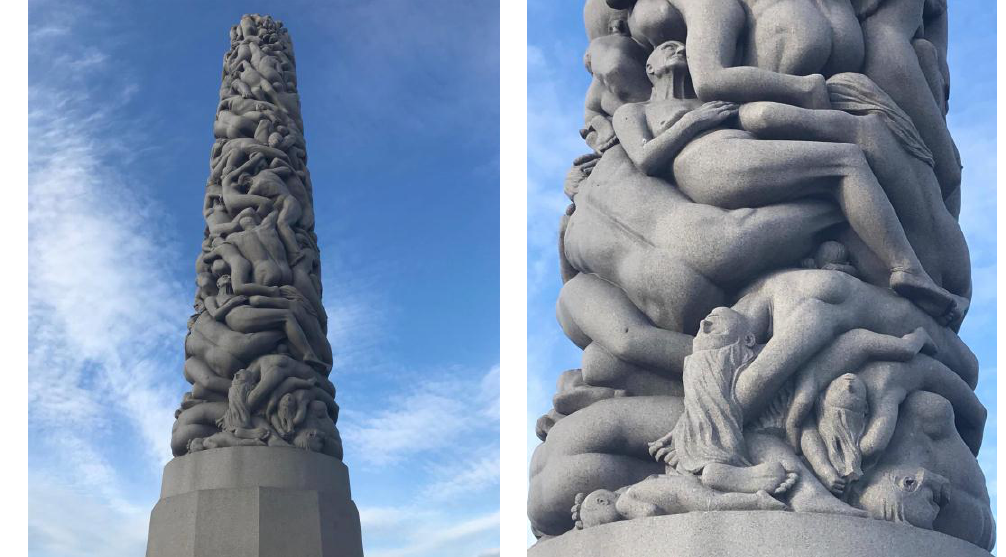
Figure 3. Forty-six-foot high monolith by Gustav Vigeland with 121 human figures. Vigeland Sculpture Park inside Frogner Park in Oslo, Norway © Amila Becirbegovic.